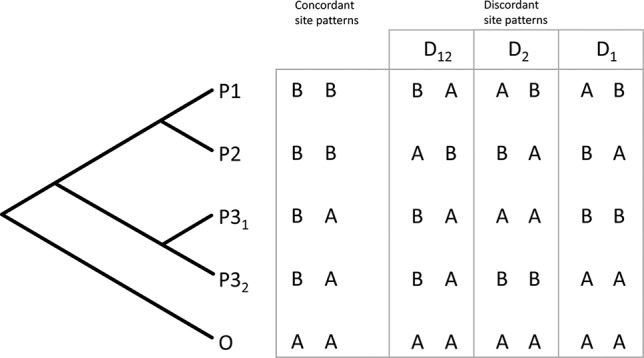
The principle of five-taxon D-statistics test. Biallelic site patterns are quantified, which support or contradict the underlying symmetric phylogeny. Asymmetry of discordant site patterns is quantified to calculate three separate D-statistics characterizing introgression from the P31 taxon (D1), the P32 taxon (D2), or their common ancestor (D12) into the taxa designated P1 and P2 (Eaton and Ree, 2013).